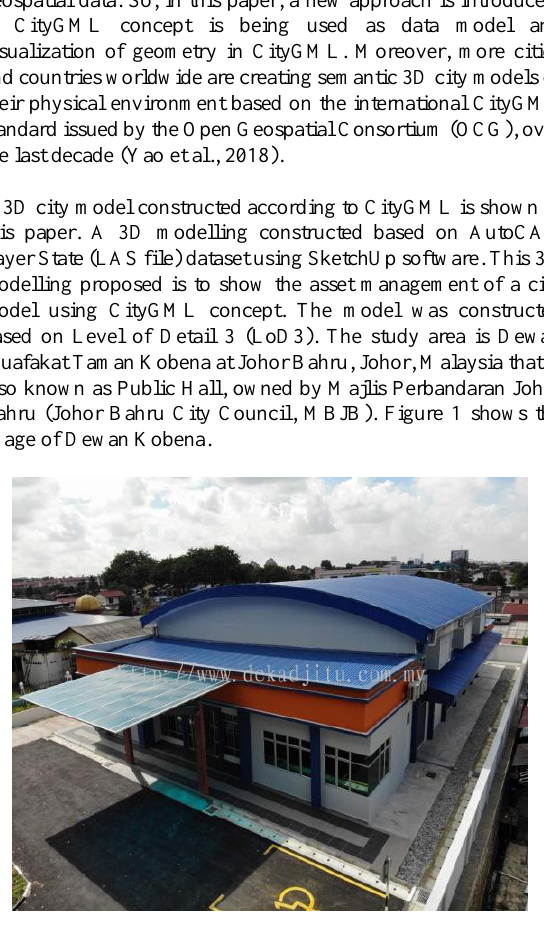
Figure 1 . Image of Dewan Muafakat Taman Kobena, Johor Bahru, Johor,